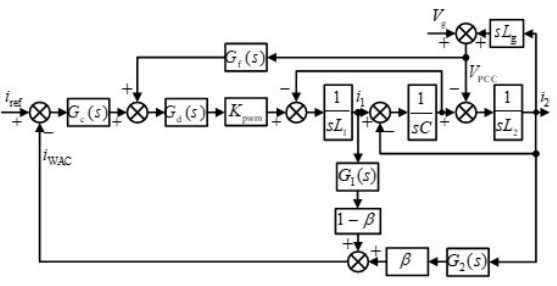
Fig. 9. Grid-connected inverter improved WAC control system structure diagram.